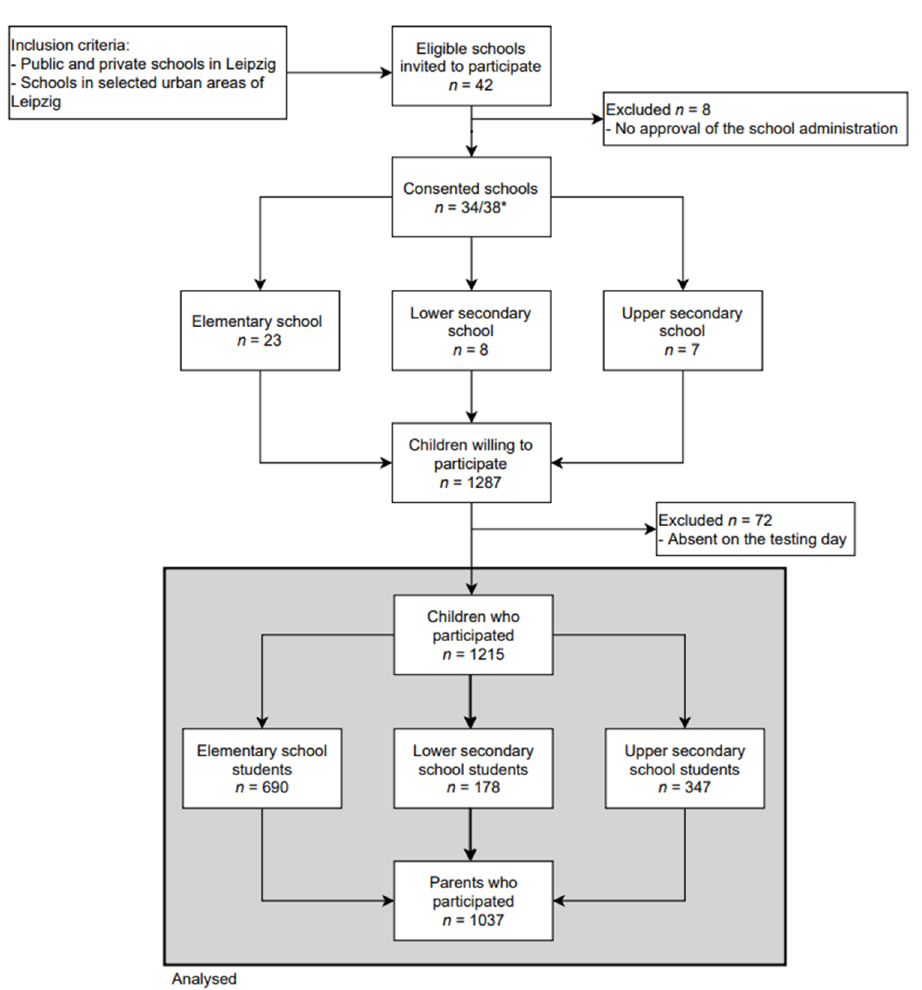
Figure 1. Flow diagram of inclusion and exclusion of study participants. * One school comprised